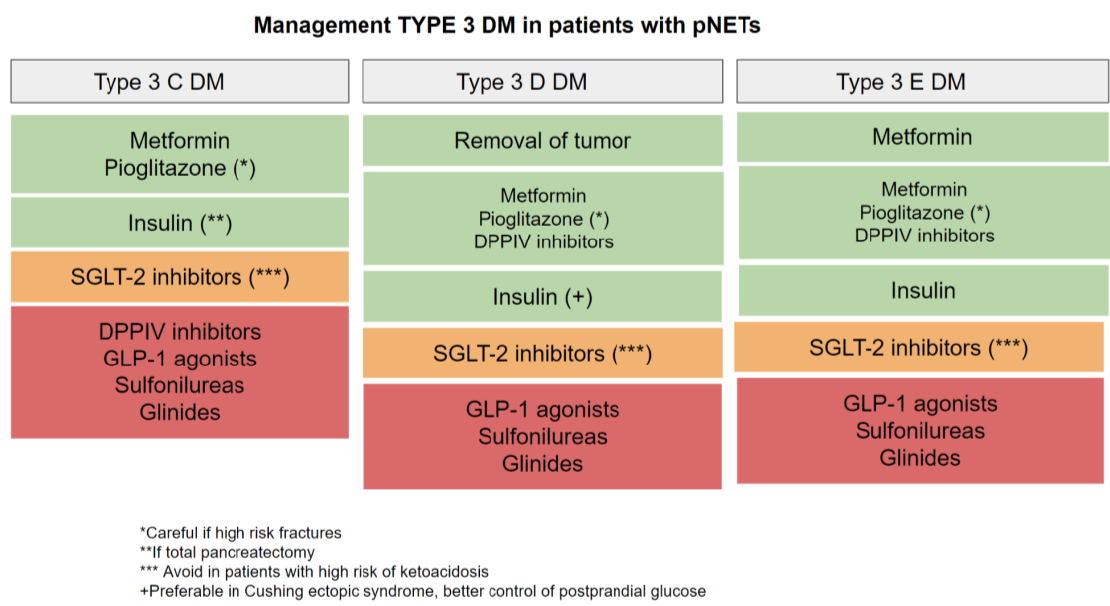
Figure 3. Pharmacological treatment of diabetes in patients with pNETs.